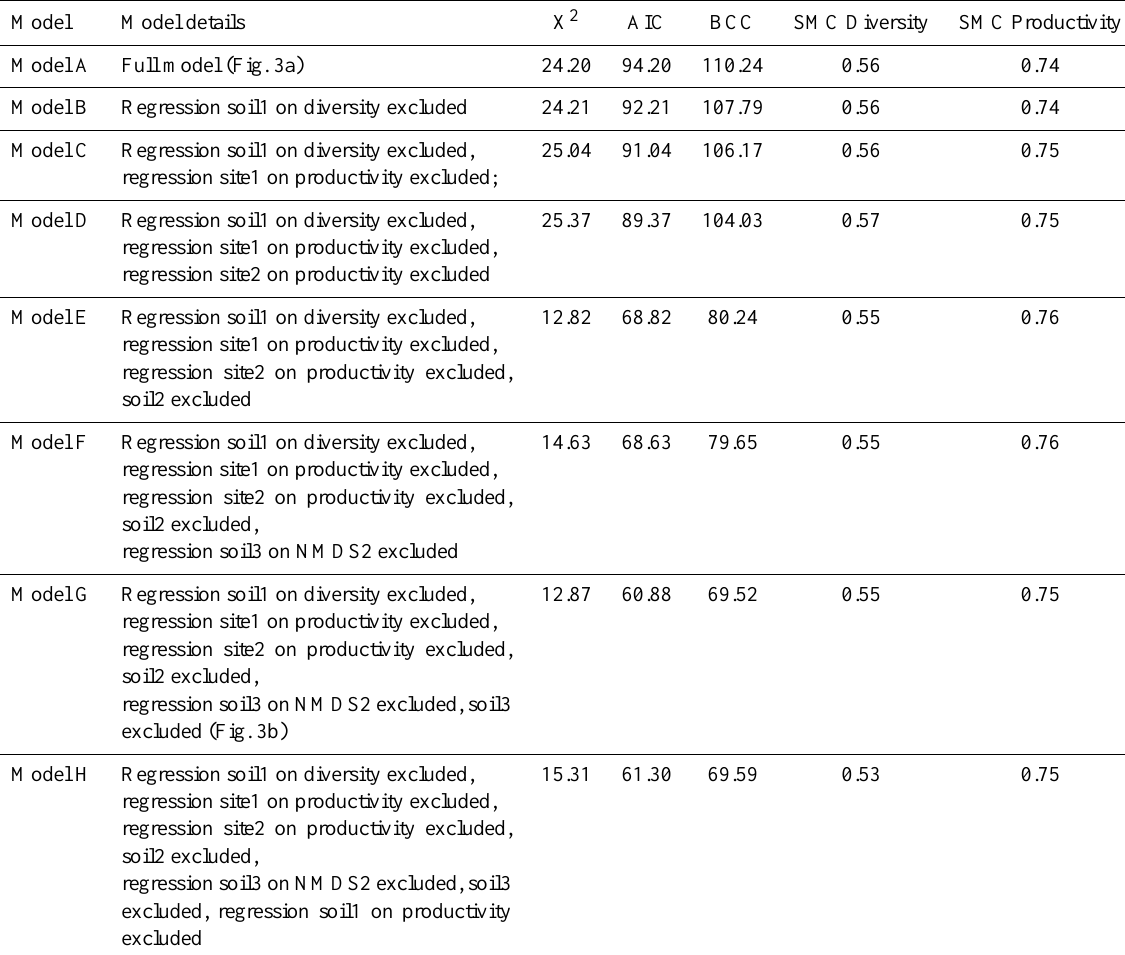
Table 3. Fitted measures for the competing structural equation models tested using the bootstrapping procedure implemented in AMOS. The most complex starting model (model A) is shown in Fig. 3a. Model G is the best-fitting model based on AIC, BCC and the SMC of variable productivity (Fig.